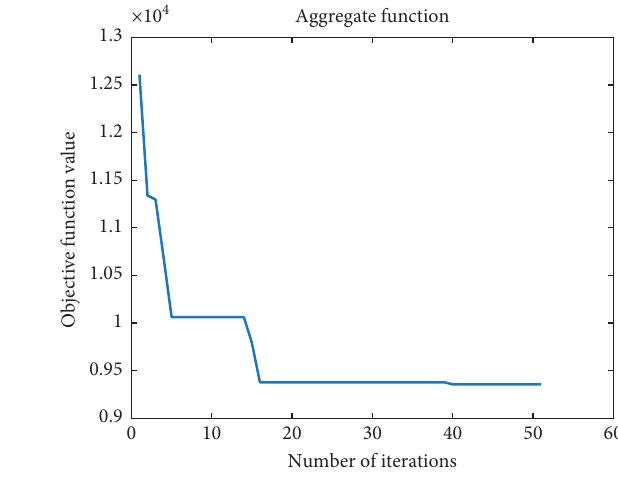
Figure 6: Scale 2 (40 customers).